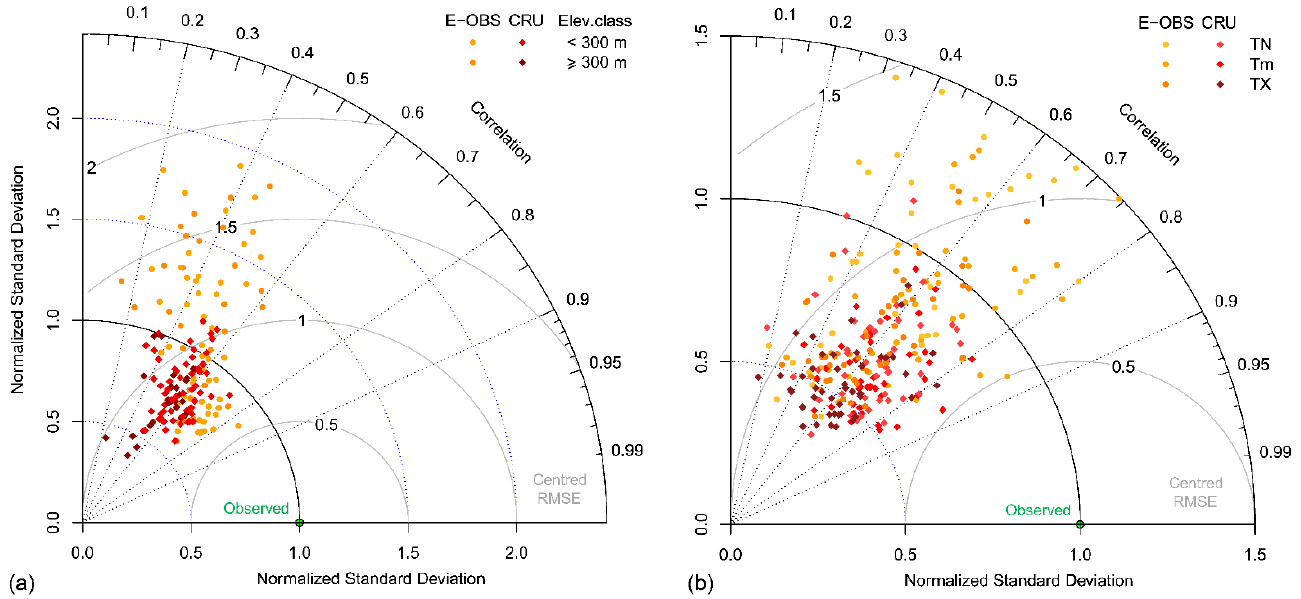
Figure 2. Taylor diagrams for assessing the performances of the E-OBS and CRU datasets in resembling the observations at the selected sites in the Apulia region: ( a ) precipitation data; ( b ) temperature data.